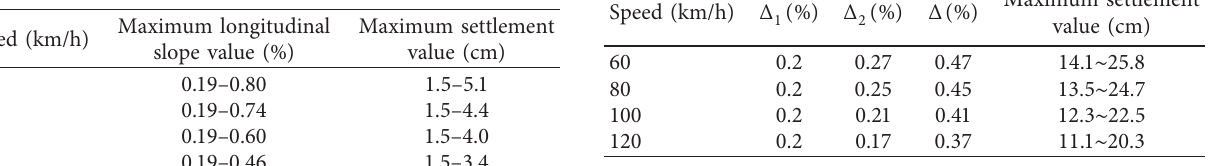
Table 4: Values of longitudinal slope and settlement of transition section corresponding to different speeds in “slightly uncomfort- able” state.